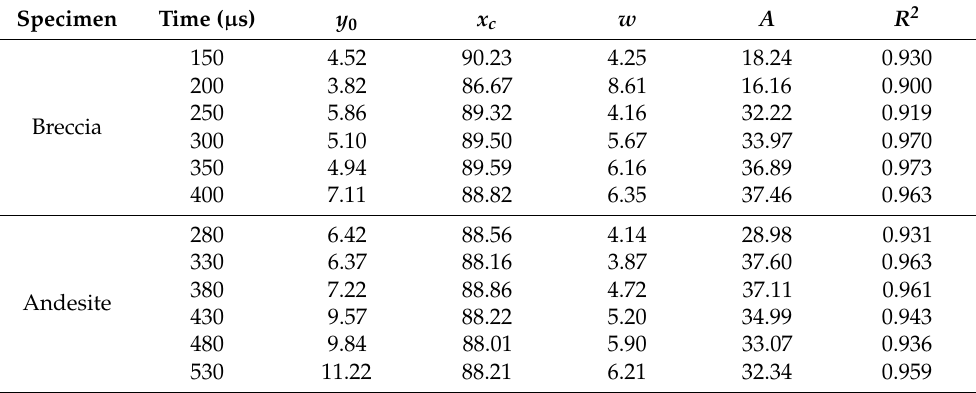
Table 1. The fitted parameters of the Gaussian